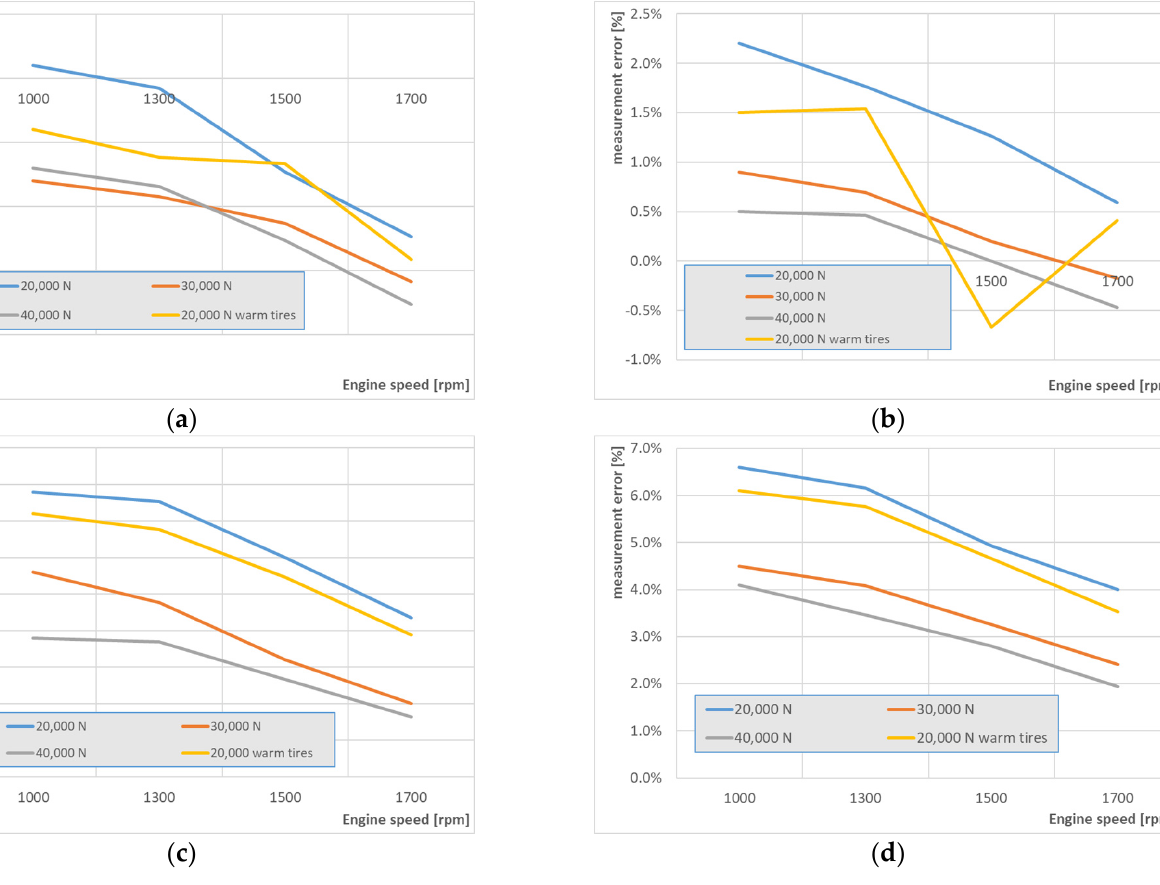
Figure 10. Graphs of errors resulting from the tire slipping on the roll for different rpm depend on engine load: ( a ) 25%, ( b ) 50%, ( c ) 75%, ( d ) 100% (authors’ source).